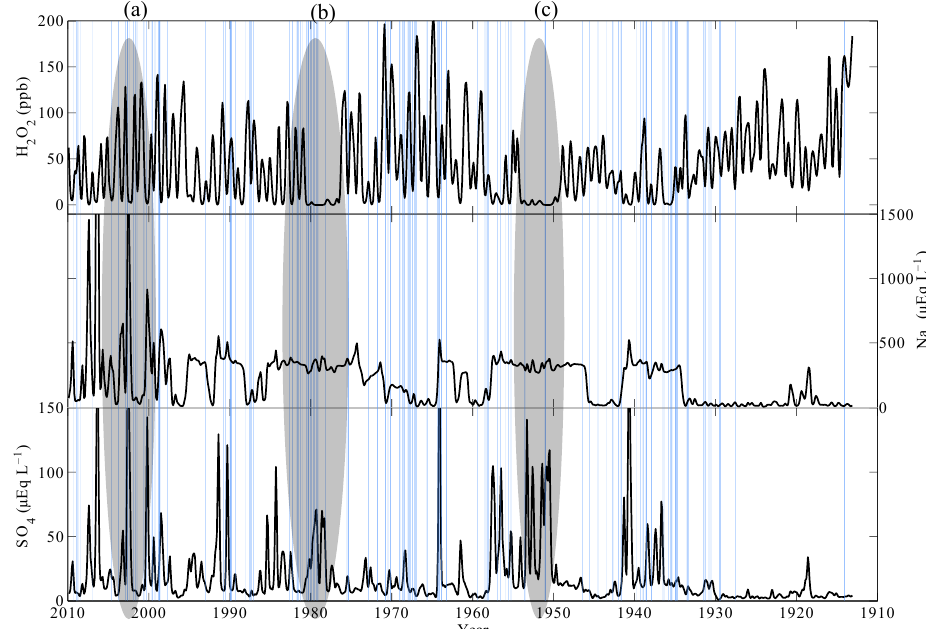
− record. The thickness of 4